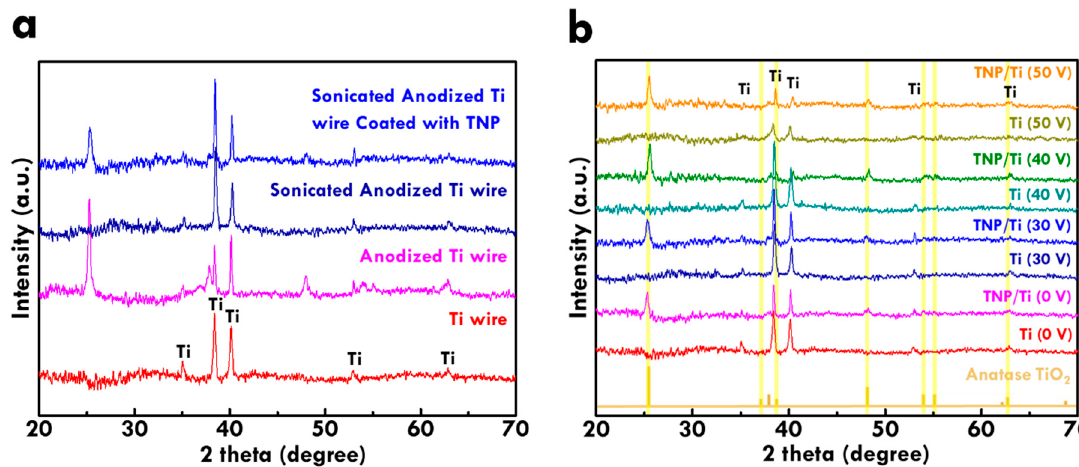
Figure 3. XRD patterns of ( a ) Ti wires under di ff erent treatments and ( b ) as-obtained Ti wire (Ti (0 V)), TNT-printed Ti wires (Ti (30 V), Ti (40 V), and Ti (50 V)), and TNP / TNT-printed Ti wires (TNP / Ti (0 V),